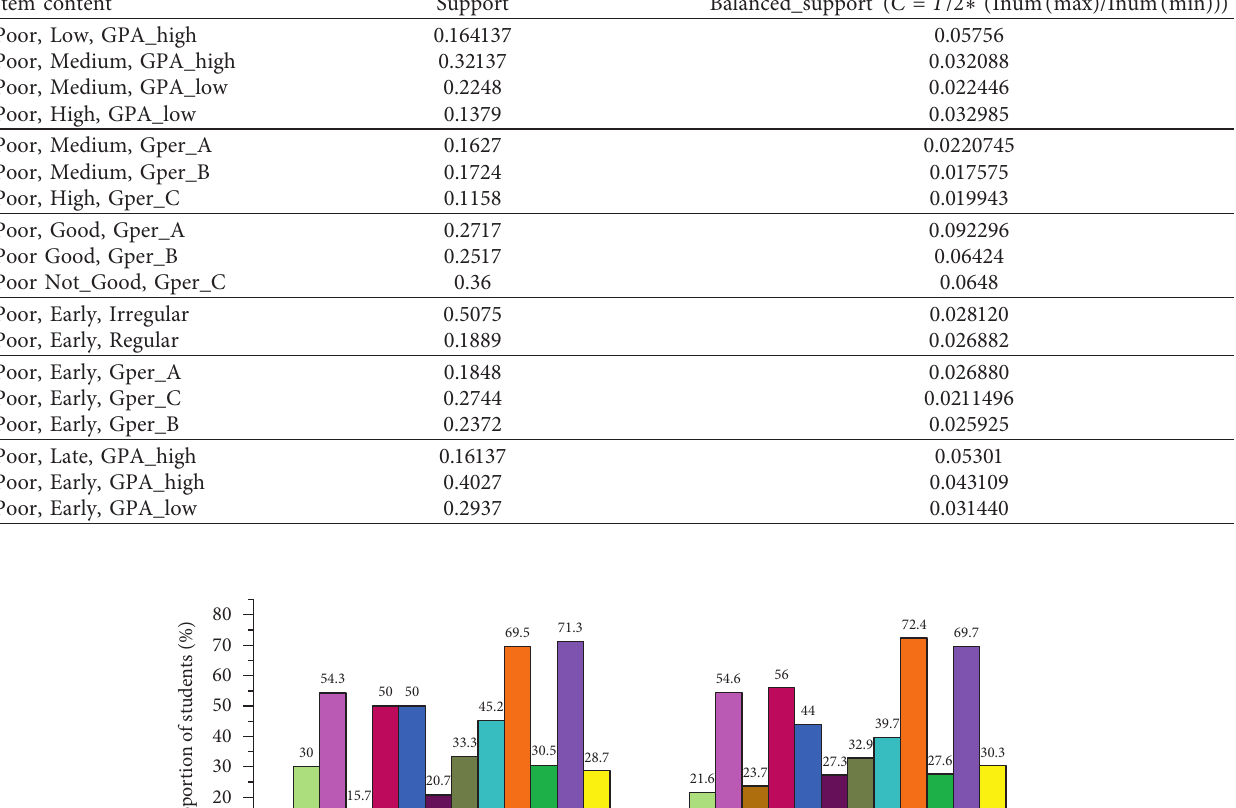
Table 11: 3-item set.